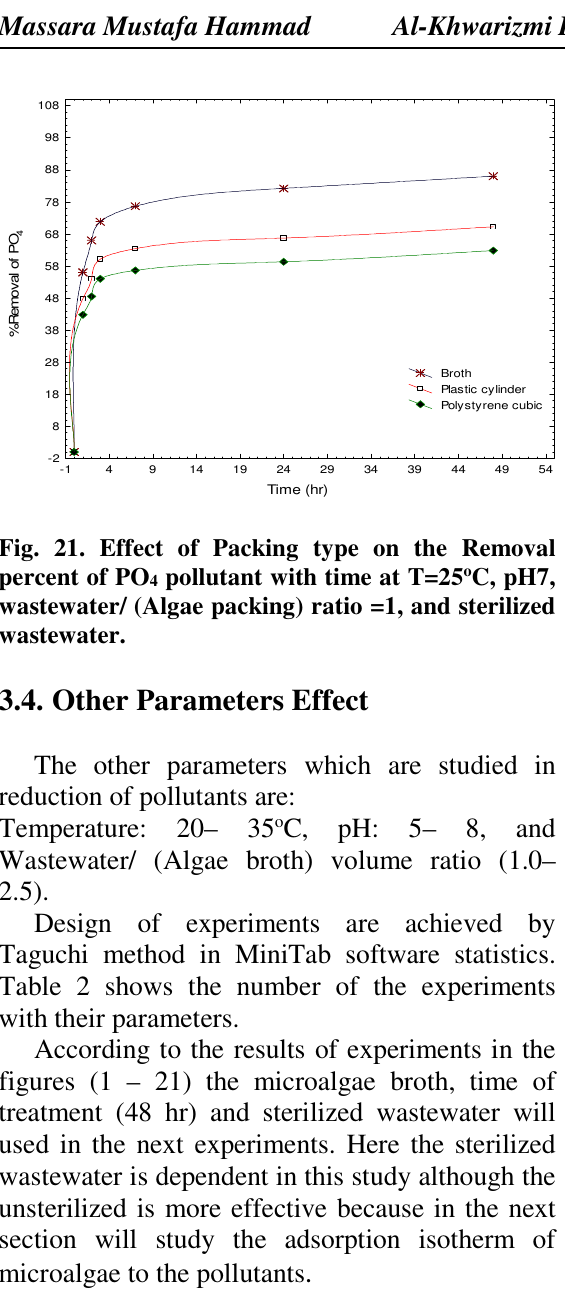
levels of the parameters studied that divided by statistical program.